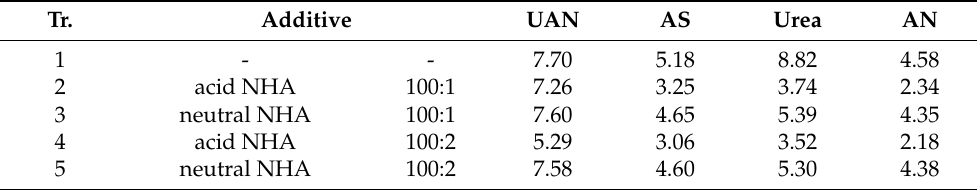
Table 1. The effect of NHAs addition on the acidity of liquid fertilizer mixtures. Tr. Additive UAN AS Urea